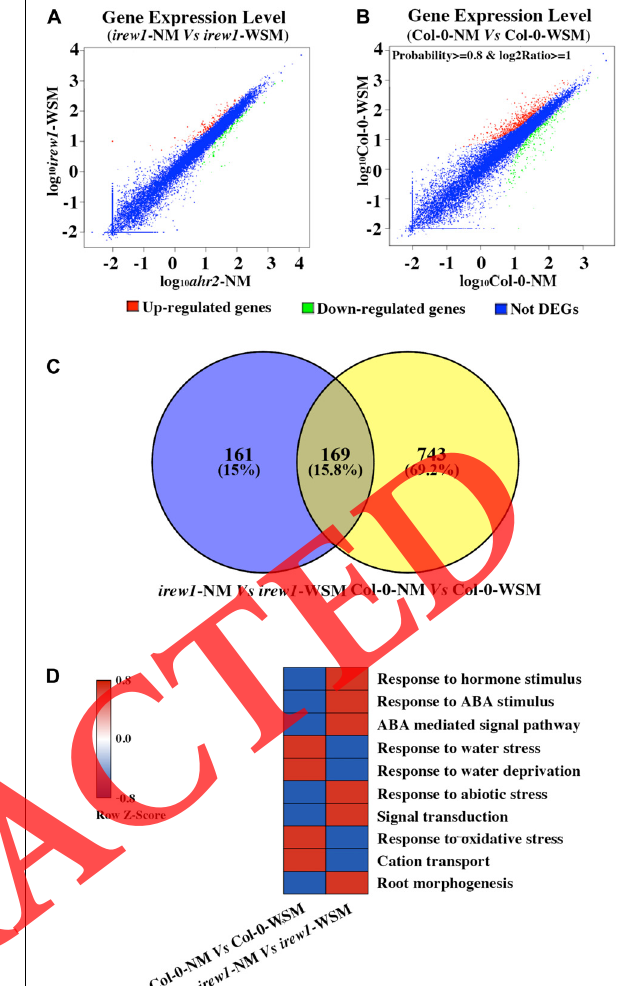
FIGURE 2 | Classification of differentially expressed genes (DEGs) of wild type (WT) Col-0 and irew1 under WSM. (A,B) Scatter plots of transcript abundance of 10 dag irew1 (A) and Col-0 (B) seedlings under NM or WSM for two days. Red, green, and blue dots represent up-regulated, down-regulated, and not differently expressed genes, respectively (Probability ≥ 0.8 and log 2 Ratio ≥ 1). (C) Venn diagram showing the number of DEGs of irew1 and Col-0 under NM or WSM. (D) Heatmap of significantly enriched gene ontology (GO) terms for DEGs. False discovery rate (FDR) was –log10 transformed and displayed as colors ranging from red to blue as shown in the